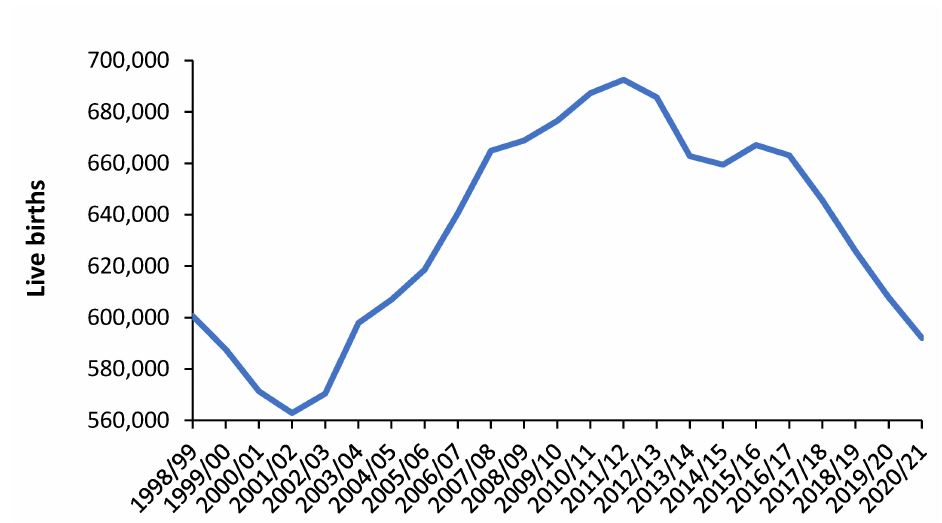
Figure A3. Trends in live births in England from 1998/99 to 2020/21. Data are from the Office for National Statistics [61].